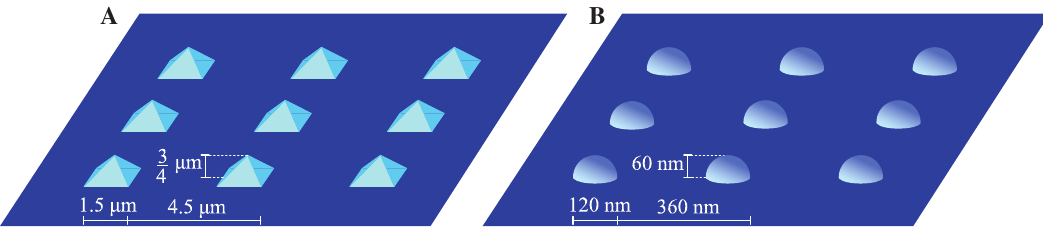
Figure 1 Two typical semiconductors with periodic distributions of (A) pyramidal and (B) spherical